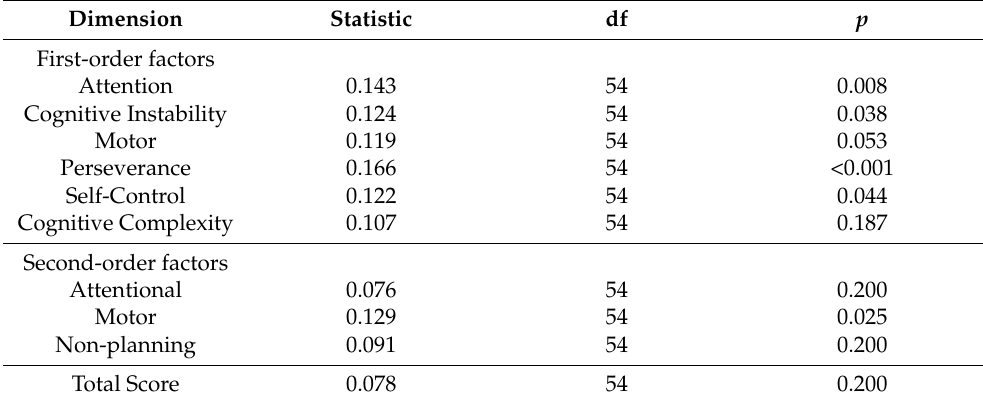
Table A1. Testing for parametric distribution in the BIS-11 using the Kolmogorov–Smirnov test with significance correction according to Lillefors. Abbreviations: df, degrees of freedom; p , significance.